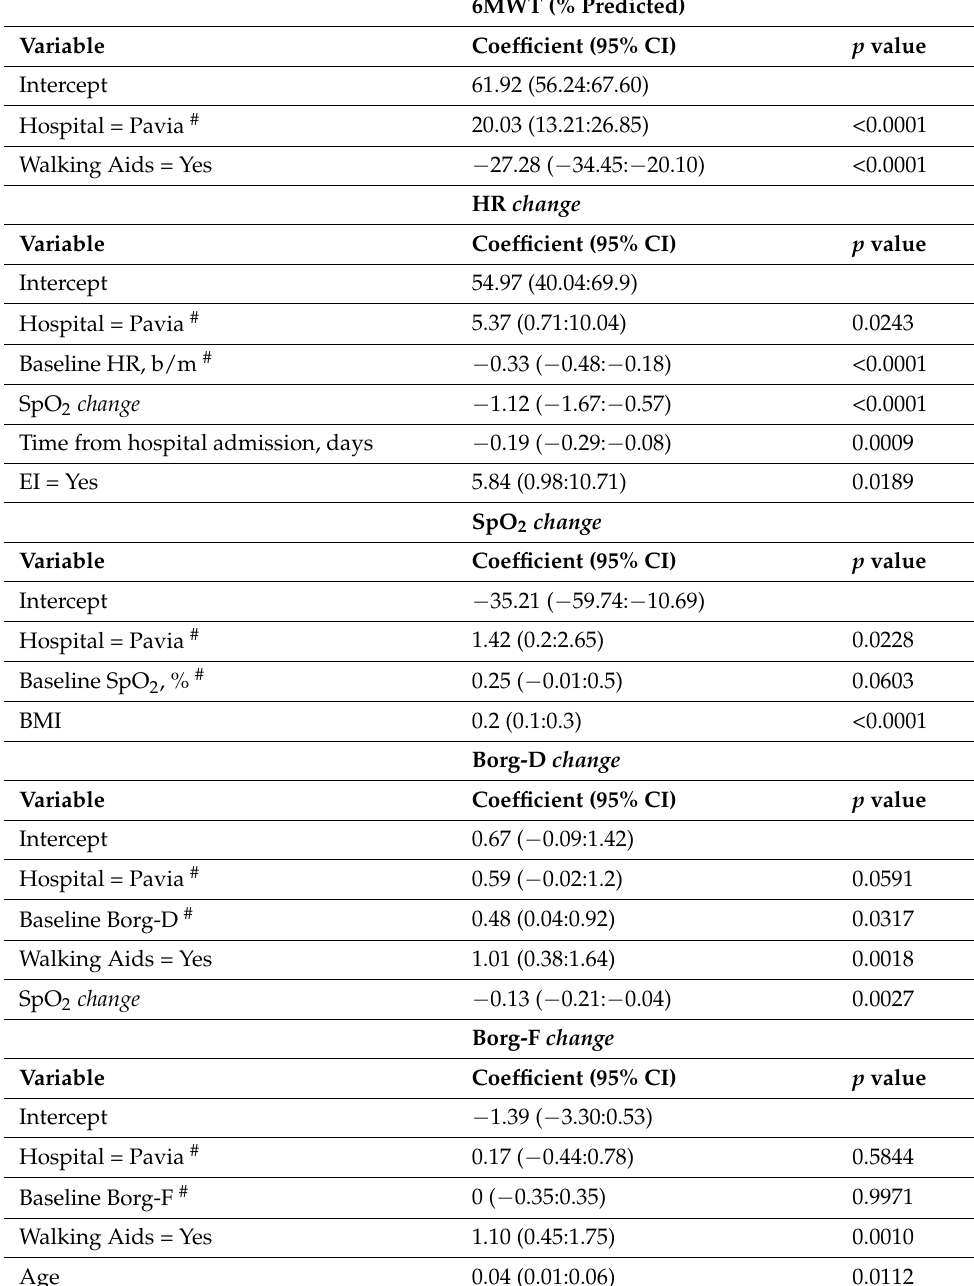
Table 3. Variables informative with respect to 6MWT % pred, HR % change , SpO 2 change , Borg-D change , and Borg-F change